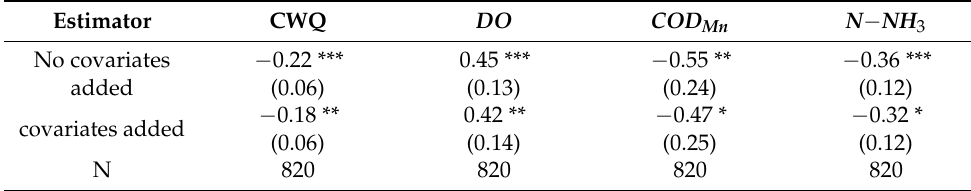
Table 4. Empirical results of the effectiveness of the RCS.